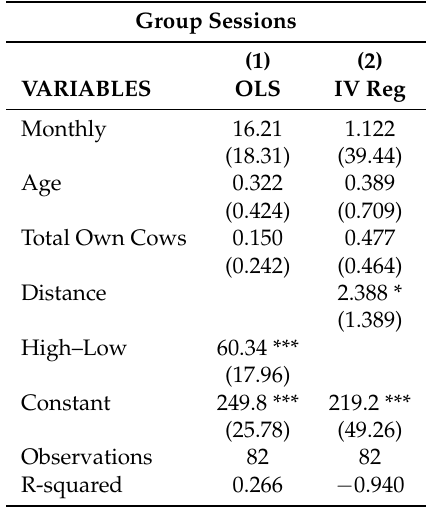
Table 8. Effect of Distance on the Amount of Insurance Purchased in